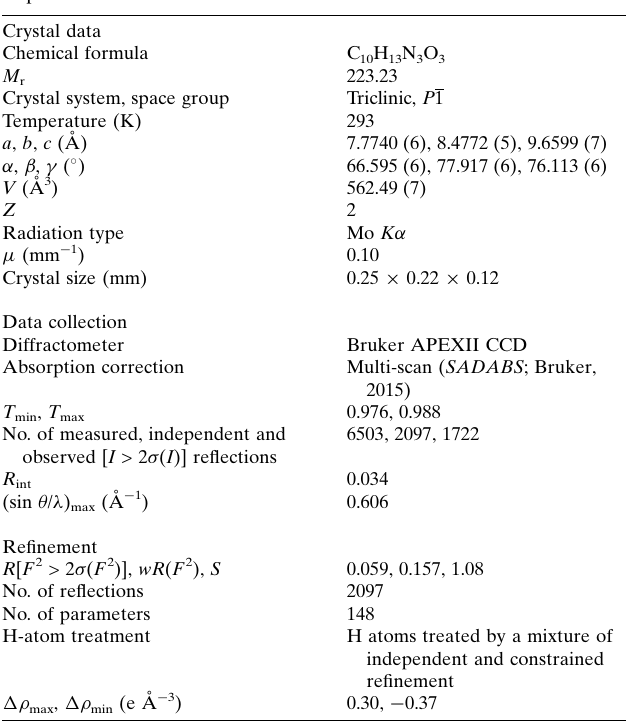
Table 2 Experimental details.